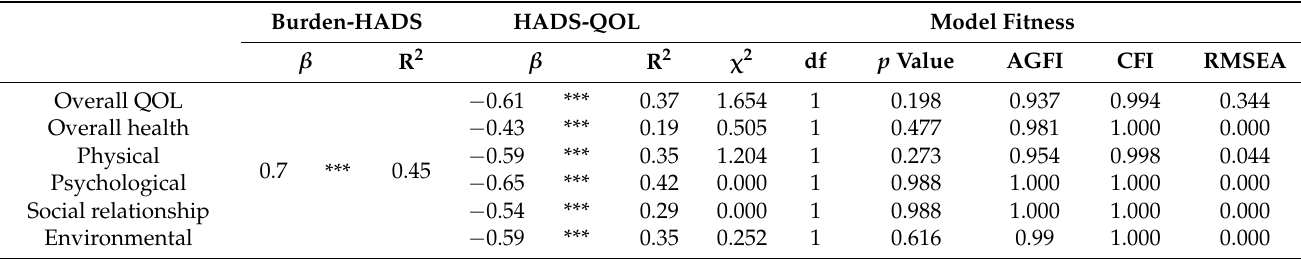
Table 6. Path analysis: model fitness of all QOL domains ( n =